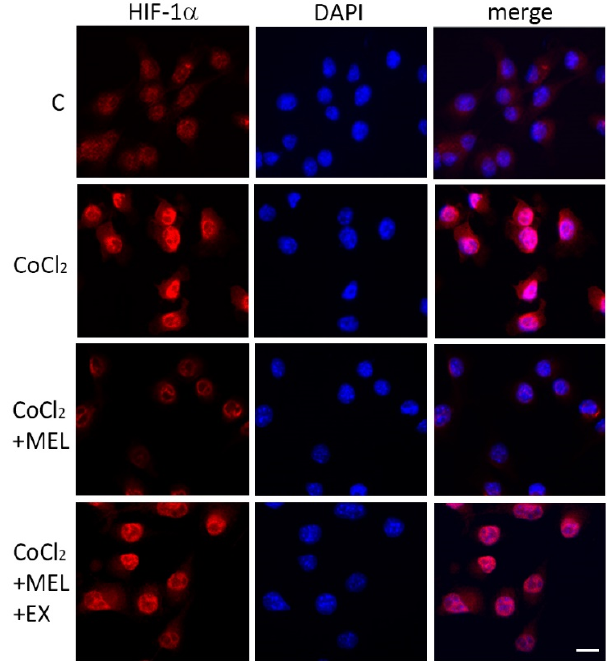
Figure 5. CoCl 2 induces hypoxia-inducible factor (HIF)-1 α in microglia. Immunostaining of HIF-1 α (red) and nuclear counterstaining with DAPI (blue) in BV2 cells following exposure to CoCl 2 alone (250 μ M for 8 h) or in the presence of melatonin (1 μ M) and melatonin + EX527 (5 μ M). Representative images are shown. Scale bar = 20 μ m.